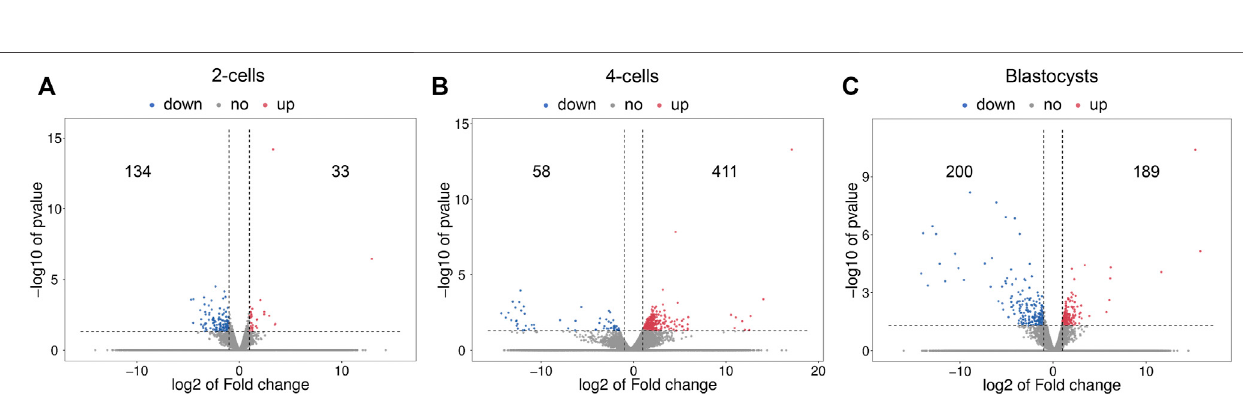
FIGURE 2 | Volcano plots ofdifferentially expressed mRNAs in (A) 2-cells, (B) 4-cells and (C) blastocysts derived from vitri fi ed porcine cloned zygotes. Red points indicate signi fi cant up-regulated mRNAs, blue points indicate signi fi cant down-regulated mRNAs, while grey points indicate mRNAs without differences. The X-axis represents the log2 fold change, Y-axis means the − log10 ( p